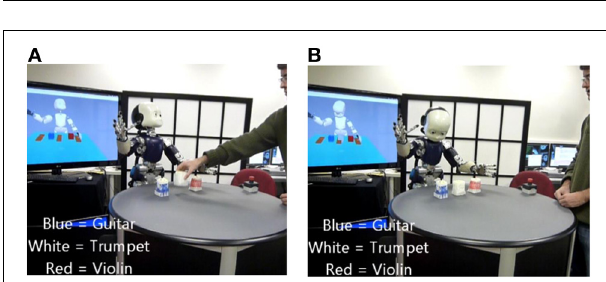
FIGURE 7 | “Scene Description” condition. The robot have to describe the scene relative to the object of focus: (A) the user sets the object of focus in the scene, where other objects are already present; (B) the robot is describing the position of the focus object relative to the other objects.